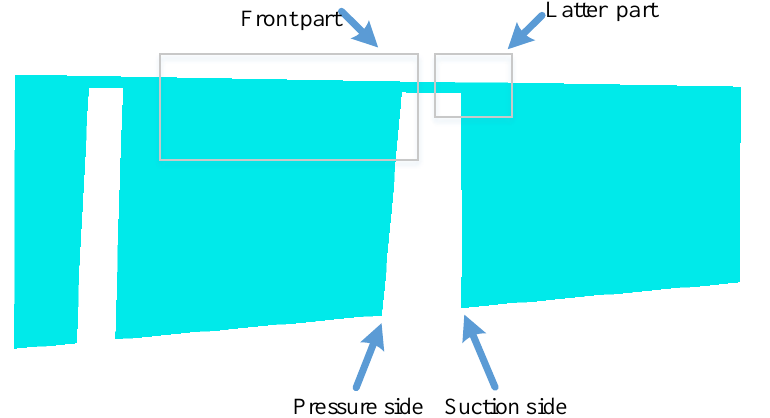
Figure 14. Observation region.